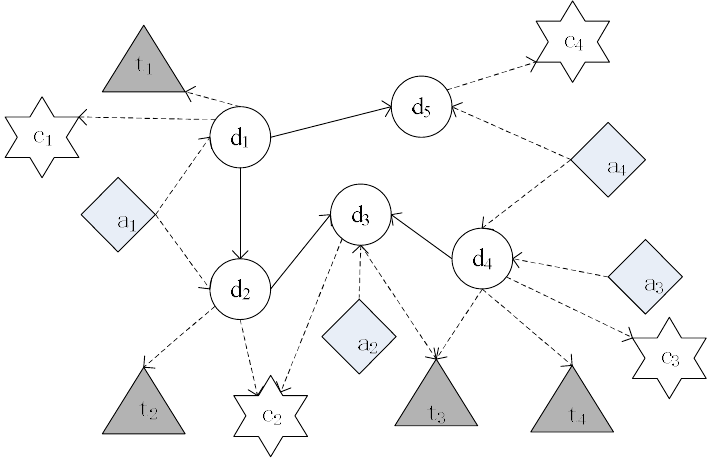
Figure 3. An example of heterogeneous academic network object relationships.